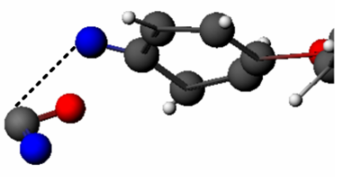
Figure 18. Breaking process of the C ‐ N bond in the PI chain due to ∙ NO treatment.